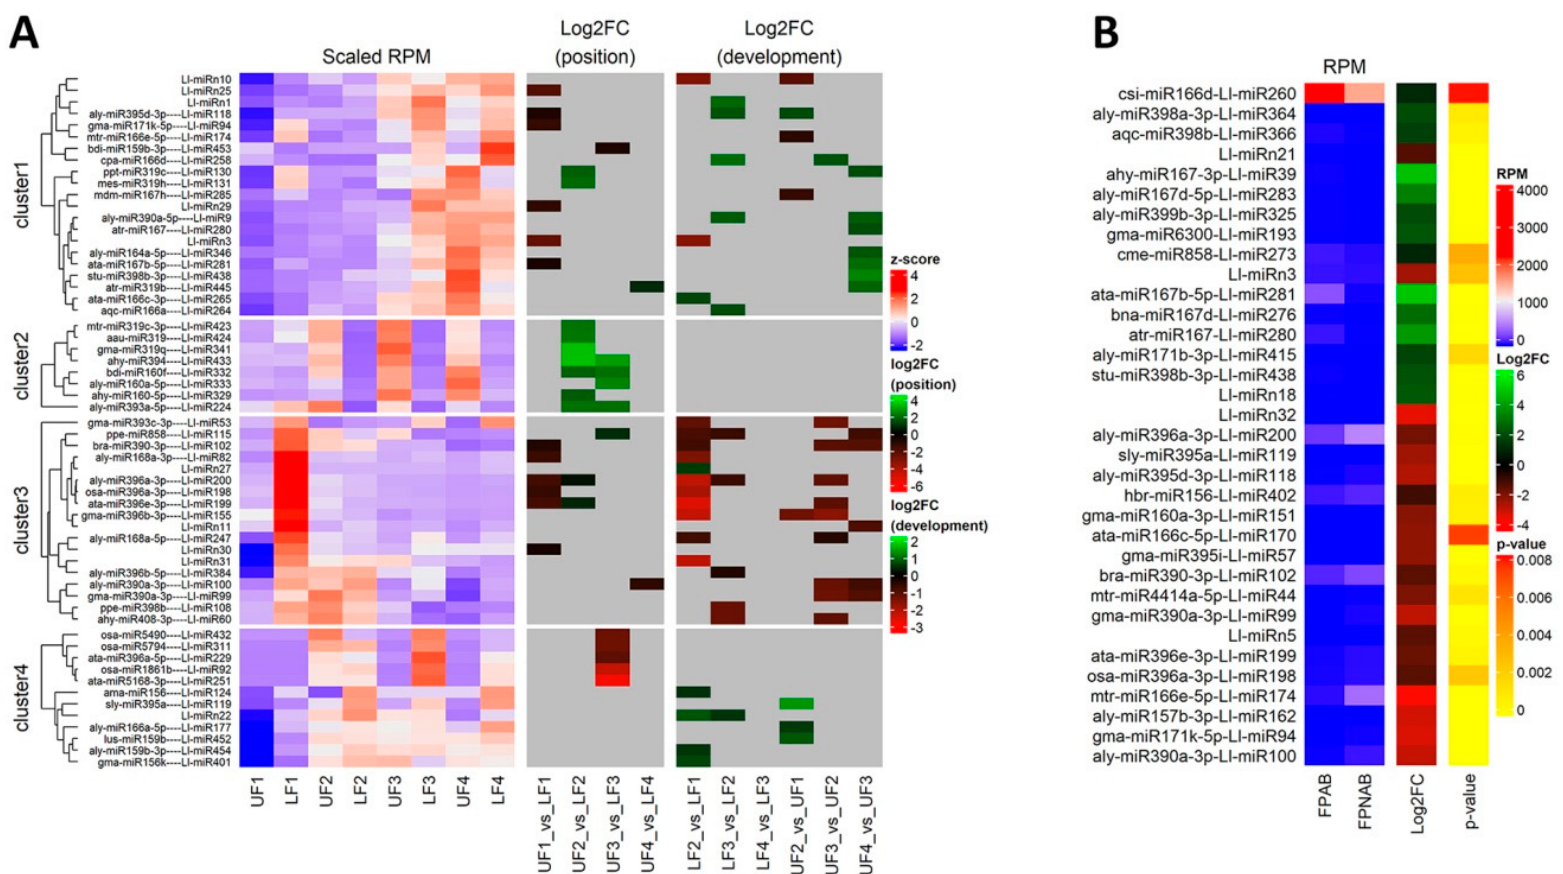
Figure 5. Differential miRNA expression in lupine flowers and flower pedicels. ( A ) Heatmaps of z-scaled miRNA expression (scaled RPM) and log 2 fold changes for either position of the flower on the raceme (Log 2 FC position) or identified between consecutive stages of flower development (Log 2 FC development). Grey indicates insignificant changes. ( B ) Heatmaps of miRNA expression, log 2 fold changes (Log 2 FC) and p -values for flower pedicels with an active or inactive abscission zone. The miRNA names are shown on the right vertical axis. Red and green represent the up-regulated and down-regulated miRNAs, respectively .